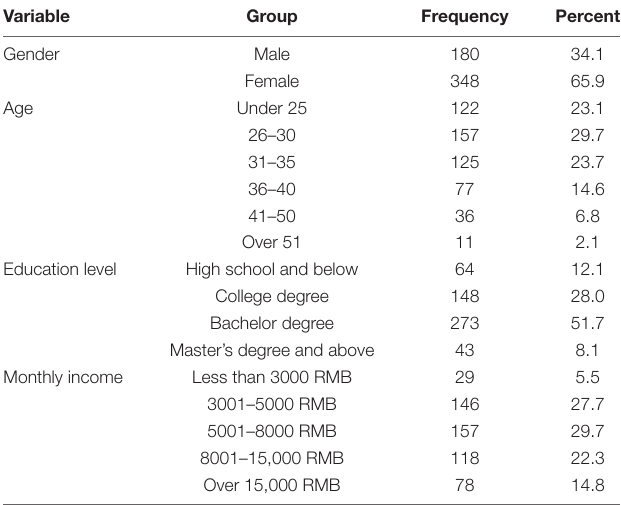
TABLE 2 | Demographics of respondents ( N = 528).